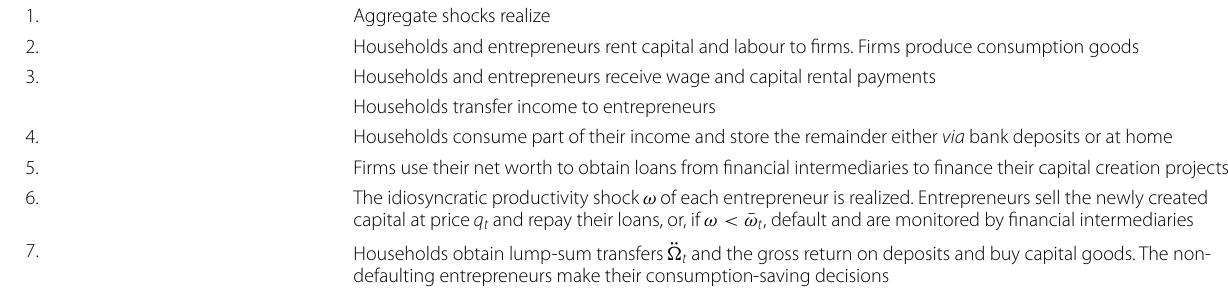
Table 6 The timing of events in a